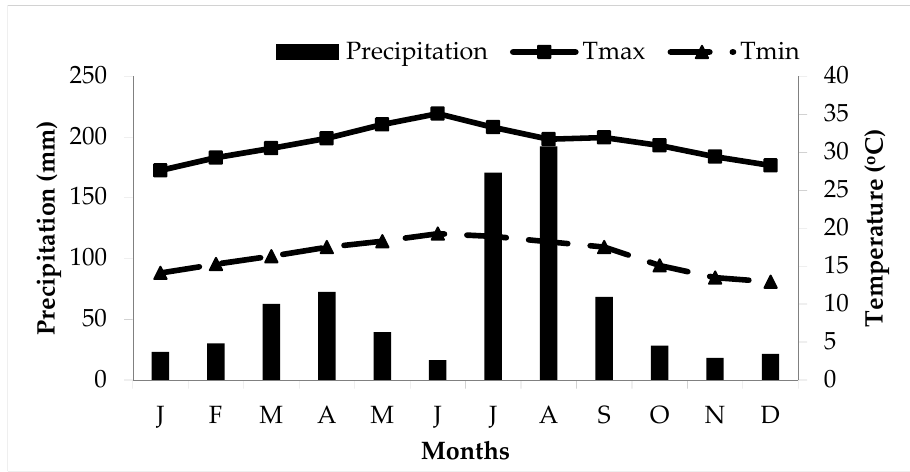
Figure 2. Mean monthly precipitation and temperature (Tmax and Tmin) selected stations in the study area (1988–2016).